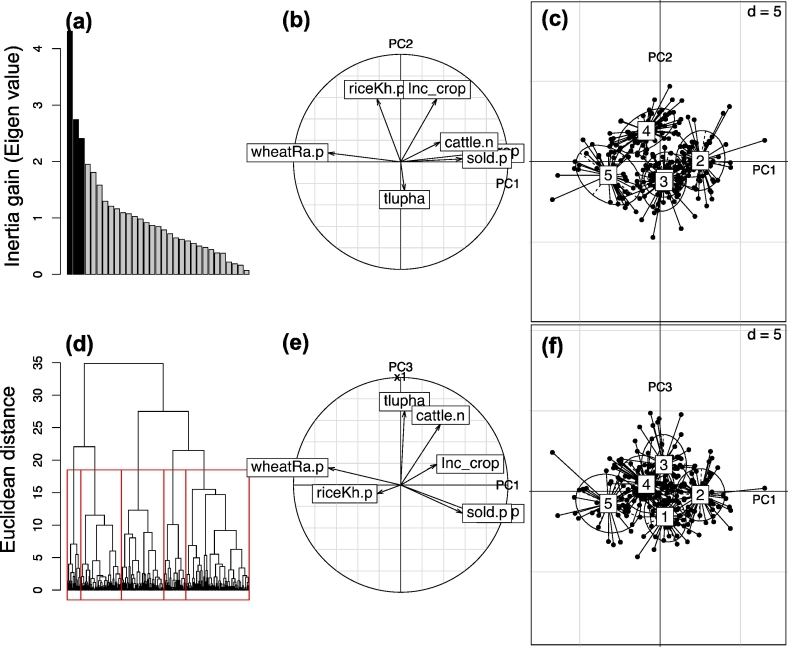
Results of the Bihar principle components and cluster analysis. (a) Variability explained by successive principle components expressed as inertia gain. The first three principle components explain 13%, 22% and 30% of the total cumulative variability. (b) Projection of variables on first two principle components, (c) Clusters projected on first two principle components. (d) Hierarchical cluster analysis dendogram depicting five clusters projected from inclusion of three principle components. (e) Variables projected on the first and third principle component. (f) Clusters projected on all three principle components.